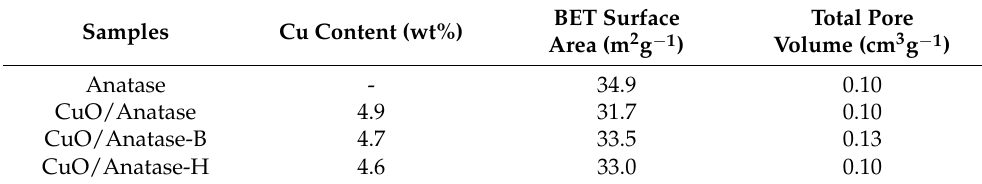
Figure 3. The ( a ) N 2 adsorption − desorption isotherms and ( b ) pore size distributions of anatase, CuO/anatase, CuO/anataseB and CuO/anataseH catalysts. Table 1. ICP-OES results and BET surface area of catalysts.